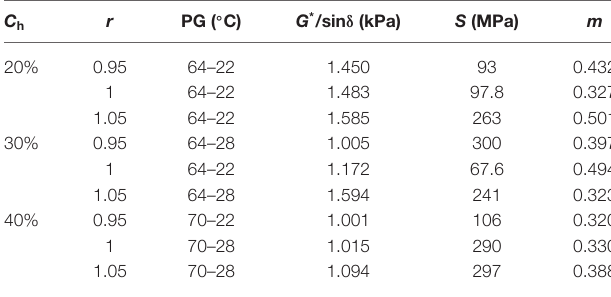
TABLE 12 | PG of polyether-based TPU-modified asphalt.